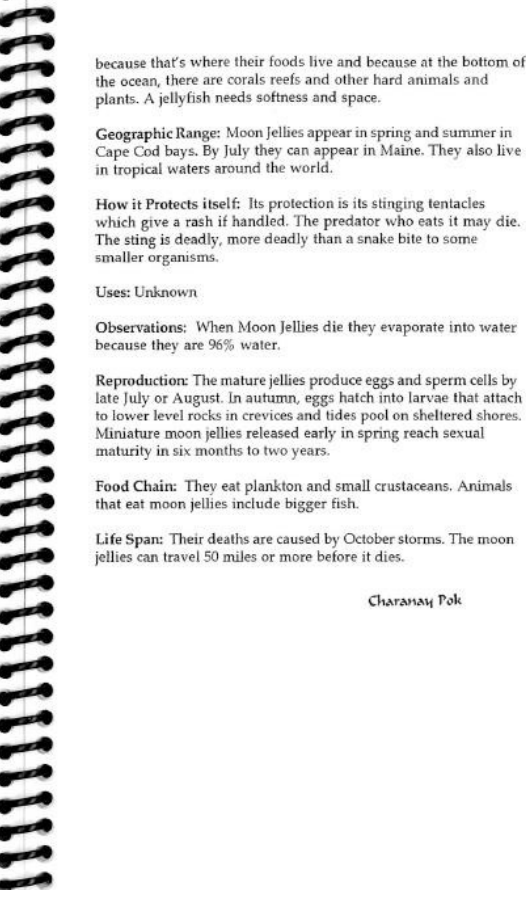
Figure 1: Shown here are two pages of a field guide called “Into the Zone: Where Land Meets the Water – A Field Guide to the Marine Life in the Tidal Zone of Northern New